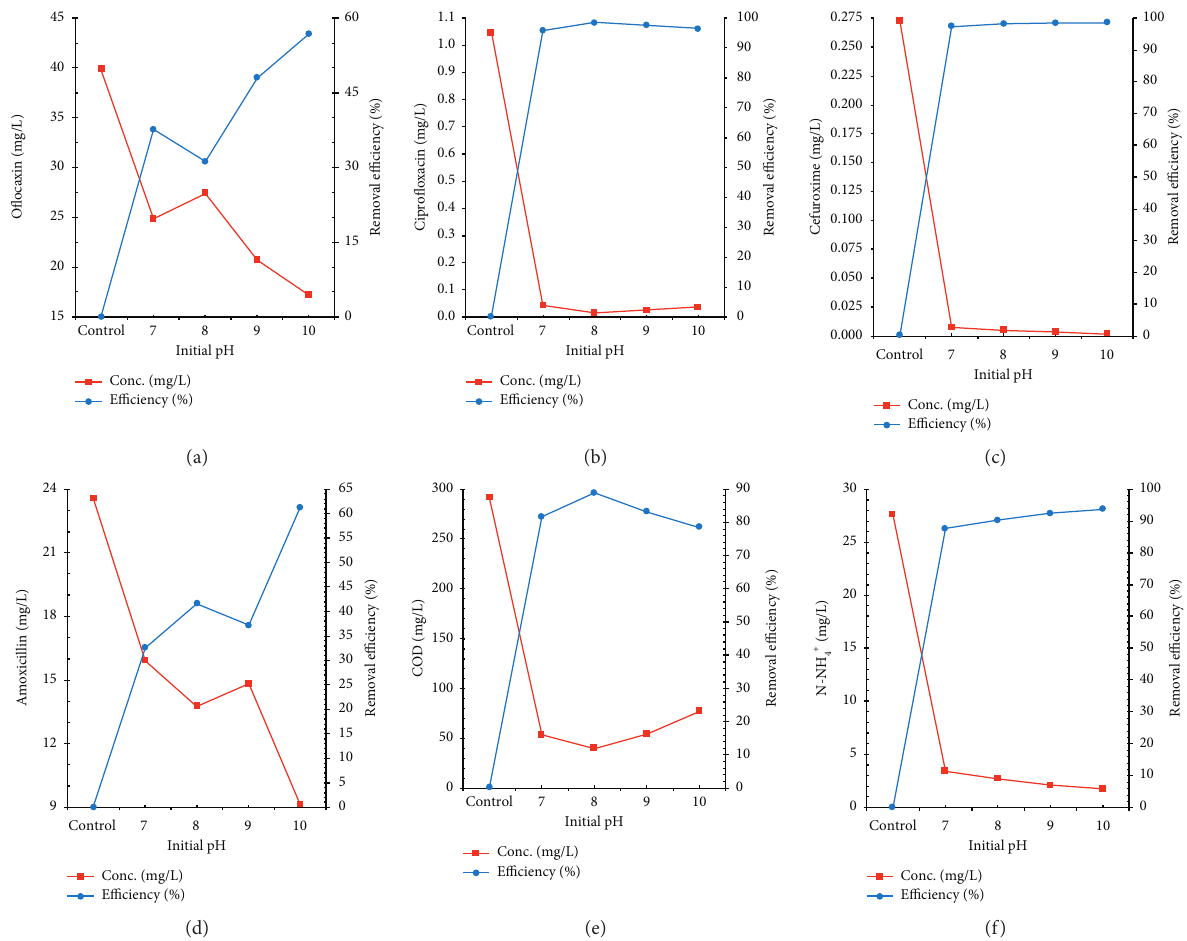
Figure 4: Effect of the pH on the degradation efficiency of four antibiotics, namely, (a) ofloxacin, (b) ciprofloxacin, (c) cefuroxime, and (d) amoxicillin, respectively, as well as (e) COD and (f) ammonia removal. Effect of the interelectrode distance of the plasma reactor.